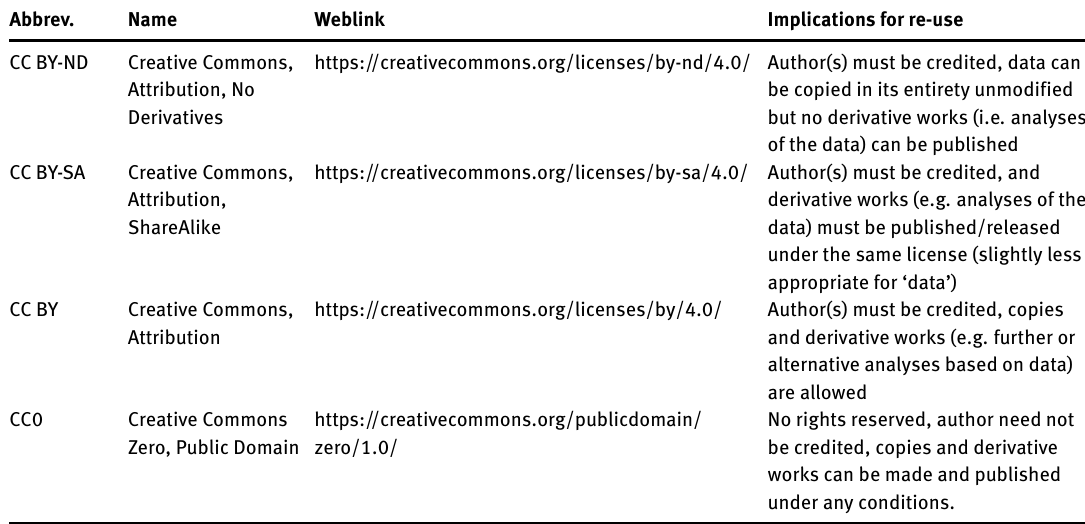
Table 4. Possible licensing frameworks appropriate for archaeological research data.